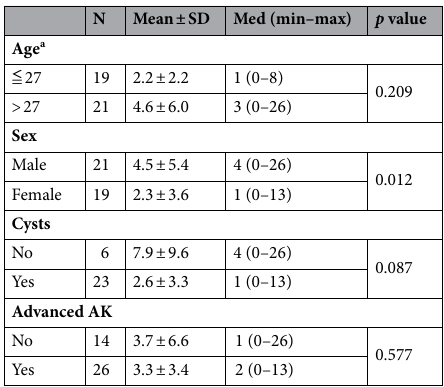
Table 3. Time from symptom onset to initial visit. a Categorization is based on a median age of 27 among